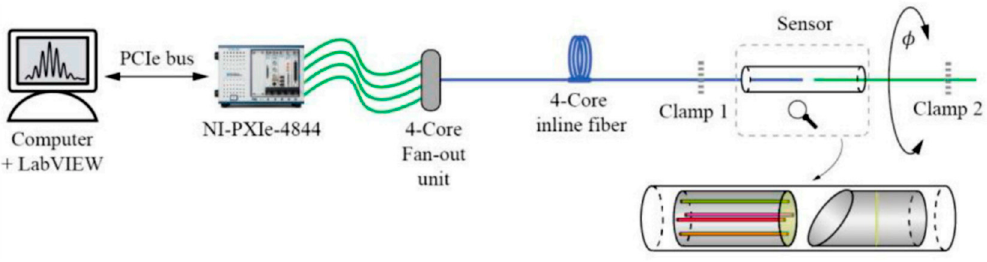
Figure 5. Schematic of the torsion sensor based on FPIs made up of a 4 ‐ core fiber [31].